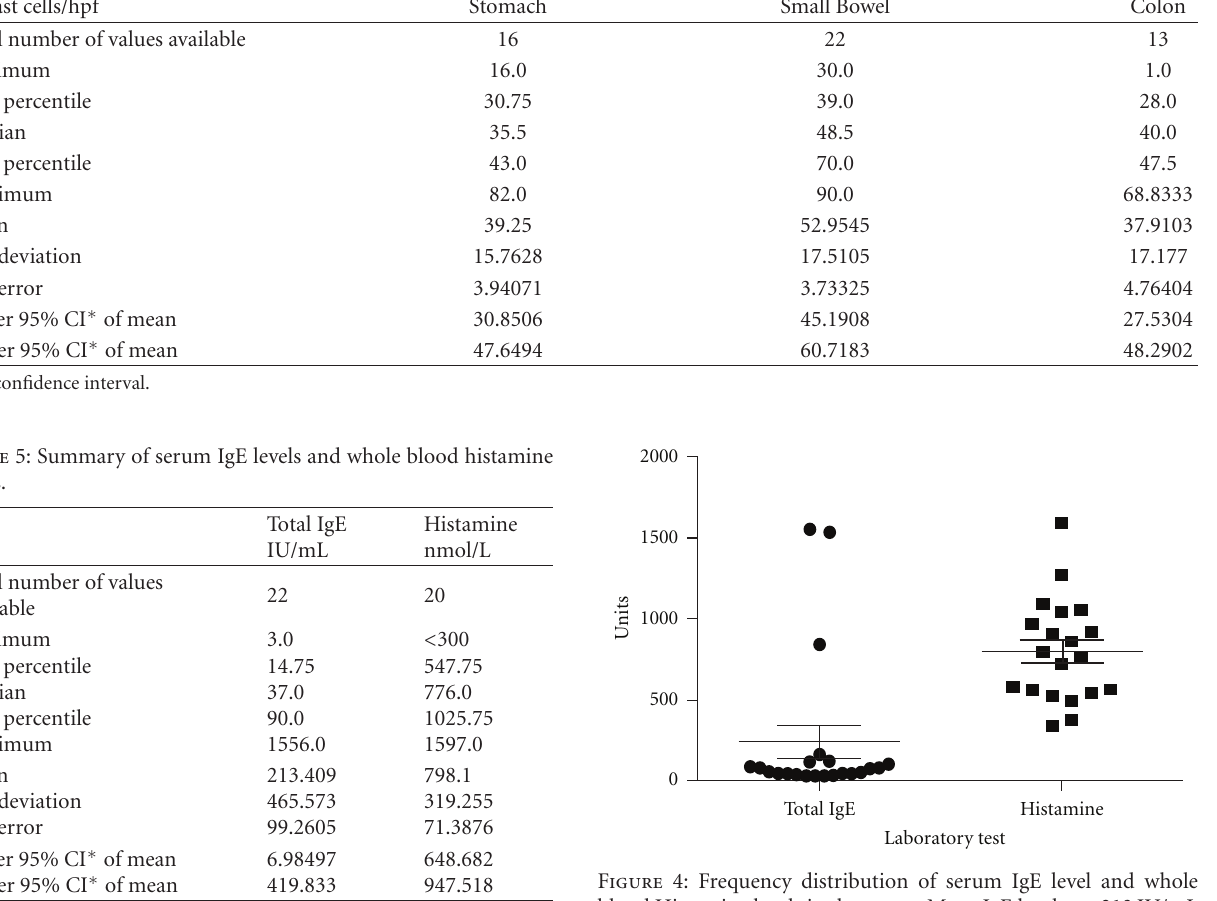
Table 4: Summary of the GI tract biopsy/CD117 staining results: number of mast cells per high power field (hpf).